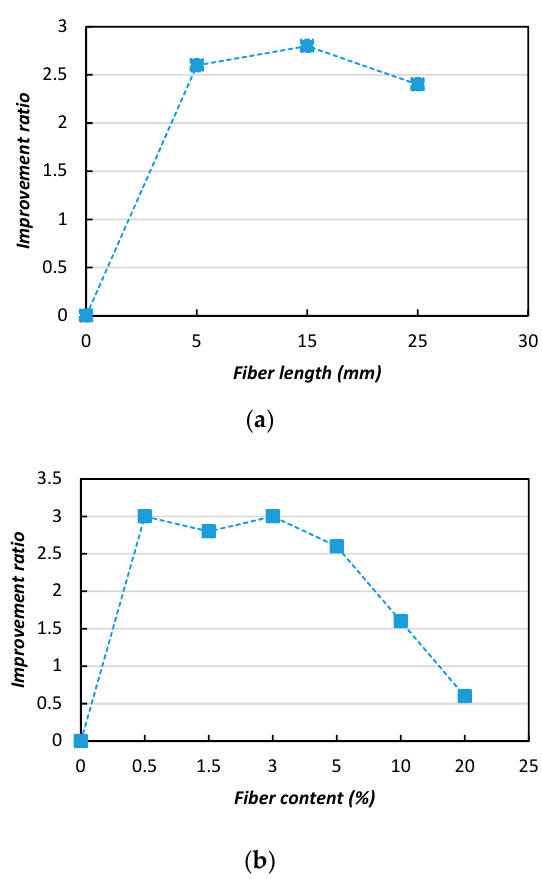
Figure 12. Improvement ratios (IRs) of the MICP-treated biocemented sample strength (UCS) with the addition of jute fibers: ( a ) fiber length; ( b ) fiber content.